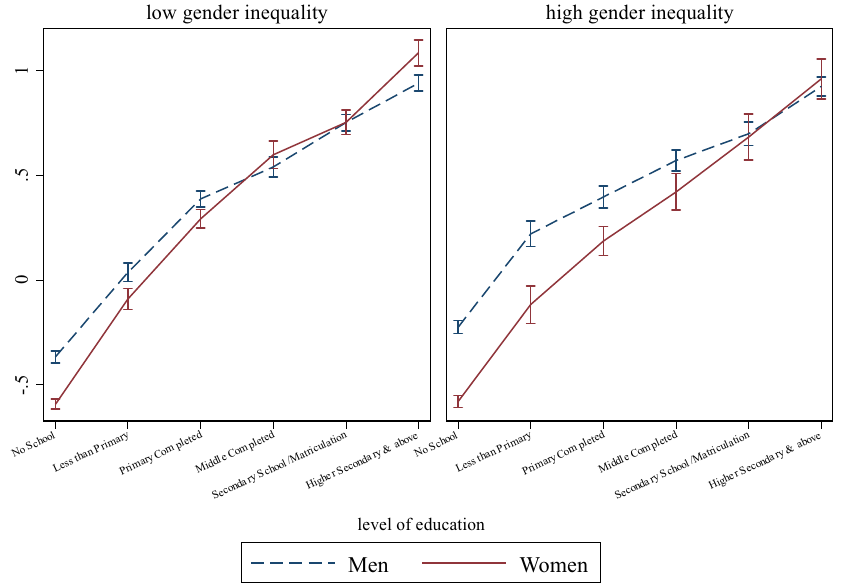
Figure 5. ( a ) Predicted cognition scores by gender, education level and region. ( b ) Predicted cognition scores by gender, education level and gender inequality. Predicted cognition scores with 95% confidence intervals are reported. Predictions are based on the estimates in Table S3. These estimates are adjusted for gender, age, caste, religion, rural/urban, region, father’s education, height, education level, and derived from regressions using survey weights. The regression model used for ( a ) includes a triple-interaction between gender, education levels, and region. The regression model used for ( b ) includes a triple-interaction between gender, education levels, and the indicator for high versus low gender inequality